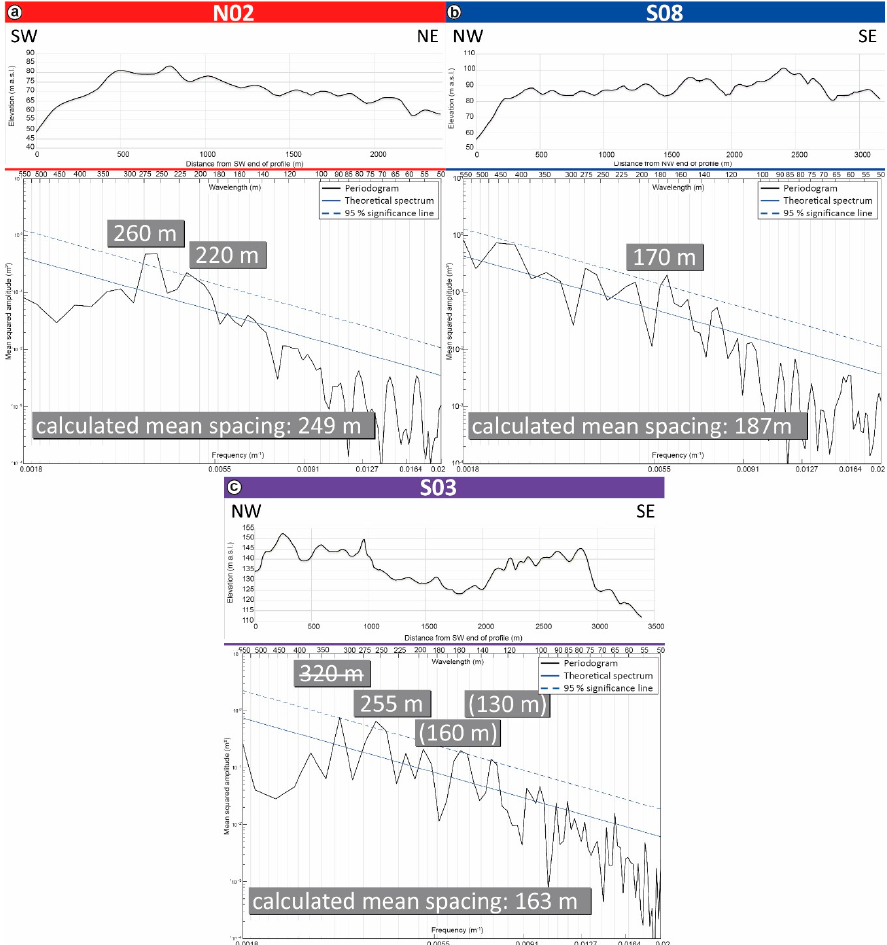
Figure 10. Elevation profiles and related periodograms of the profiles N02 ( a ); S08 ( b ); and S03 ( c ) representing the southern and northern sub-complex, and the “central zone” as the special area of the southern ridge domain. The significant wavelengths are shown in grey boxes above the related peak. The struck through value in the S03-periodogram ( c ) represents an outlier and the values in parentheses are tangent to the 95% significance line, but are still significant. Calculated mean spacing values in grey boxes support the results within the periodograms.